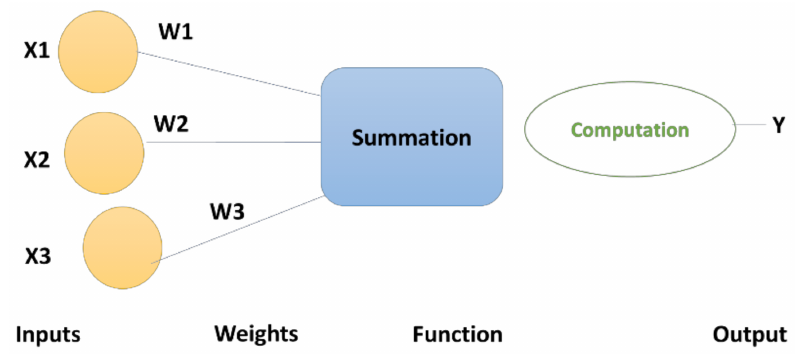
Figure 2. Illustration of an artificial neural